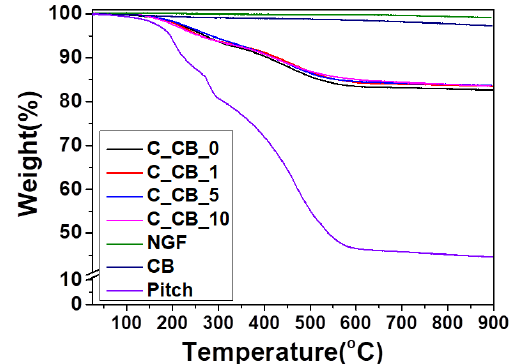
Figure 3. TGA spectrum of non-carbonized samples at a heating rate of 10 °C/min in N 2 .